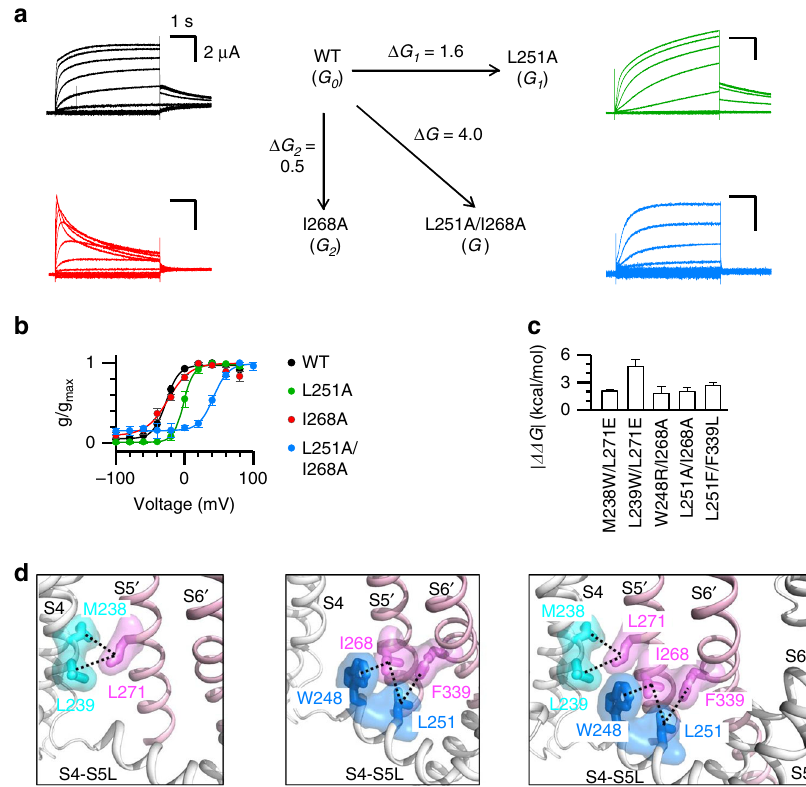
Fig. 4 E – M coupling interactions when the VSD adopts the activated conformation. a, b Double mutant cycle analysis of the interaction between L251 and I268. ΔΔ G = Δ G – ( Δ G 1 + Δ G 2 ) = 1.8 kcal/mol, which indicates interaction between the two residues. n ≥ 3. All averaged data are shown in mean ± SEM. c Double mutant cycle analysis of interactions between W248 and I268, L251 and I268, L251 and F339, M238 and L271, and L239 and L271 ( ΔΔ G = 1.4 – 4.4 kcal/mol). n ≥ 3. d Mapping the fi ve pairs of interacting residues onto the K V 7.1 cryoEM structure. Color codes are the same as in Fig. 3h. Source data are provided as a Source Data fi